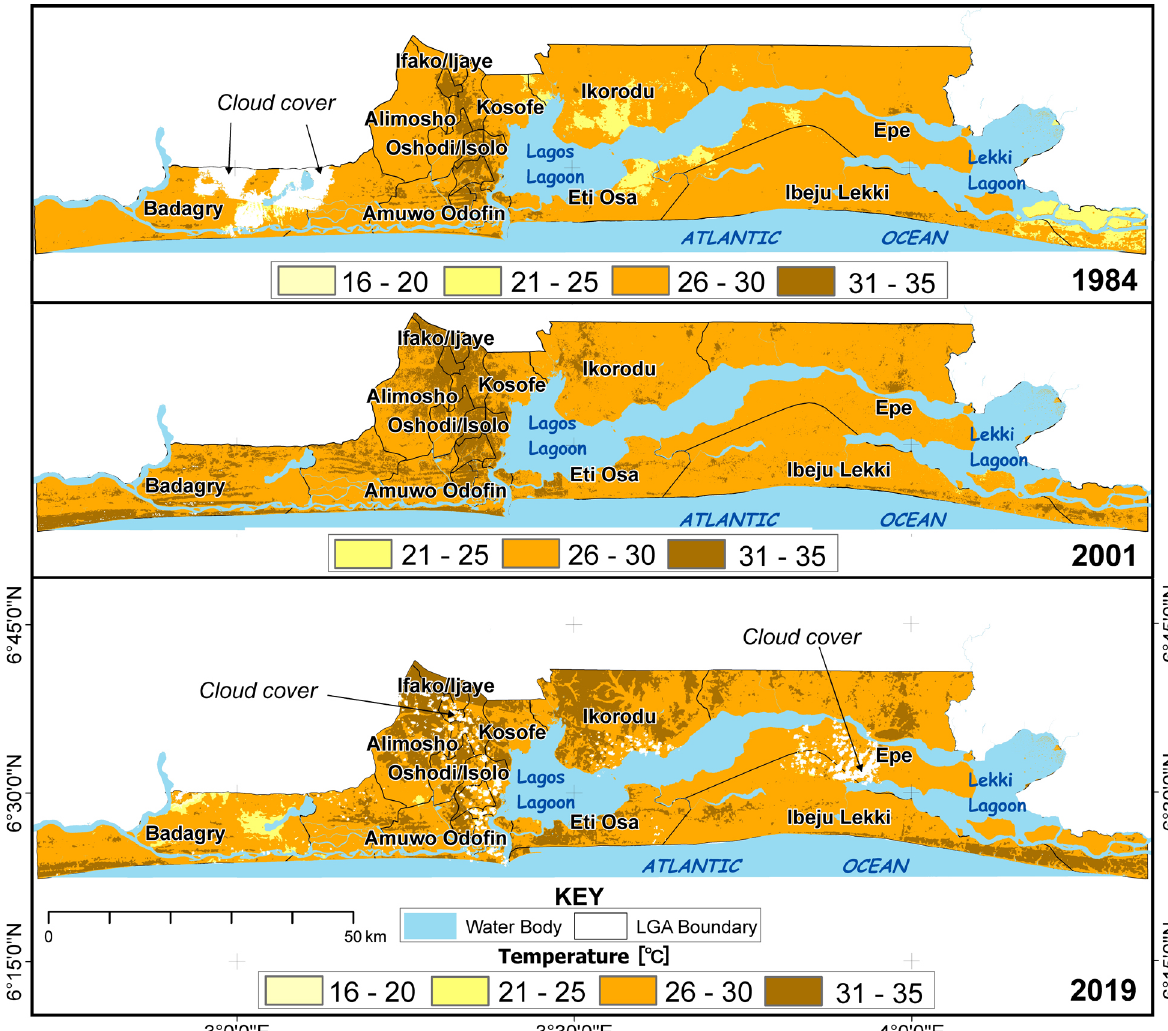
Fig. 5. Spatial variation in LST.